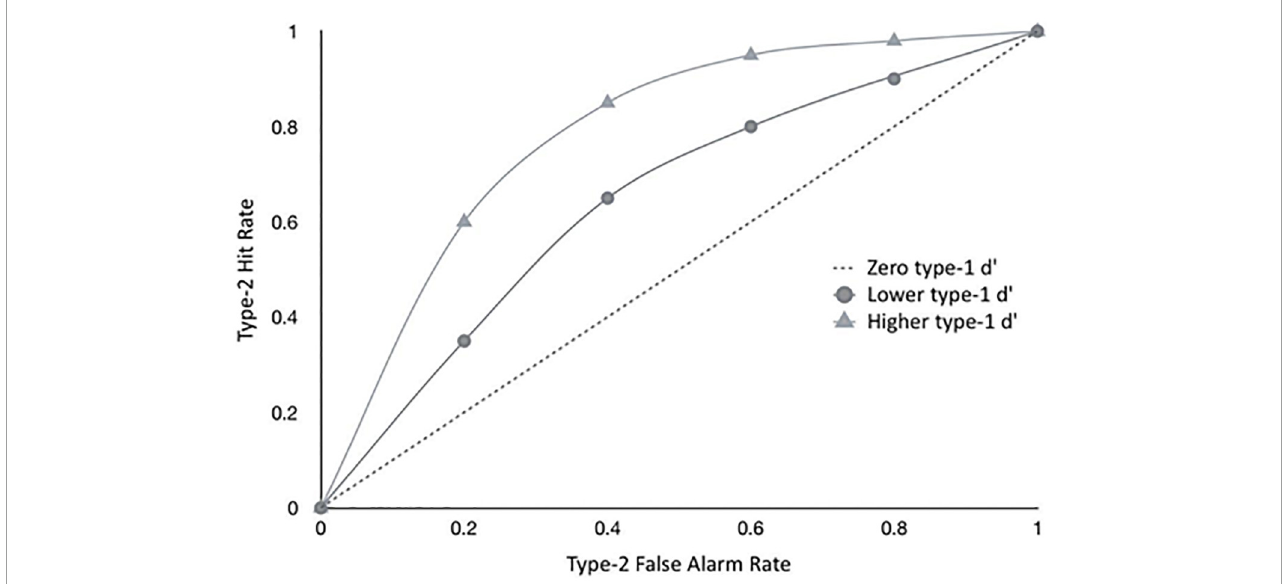
FIGURE1 The graph shows hypothetical type II ROC curves of a hypothetical observer with a given metacognitive capacity, exposed to different levels of difficulty in the primary task, implying different levels of type I sensitivity (d’). Empirical metacognitive sensitivity (type II) will be constrained by type I task difficulty - the same observer will show different levels of type II sensitivities, depending on the difficult in the primary task. This is why we only considered studies that had approximately equal type I performance levels for both participant groups. See also Fleming and Dolan (2012).